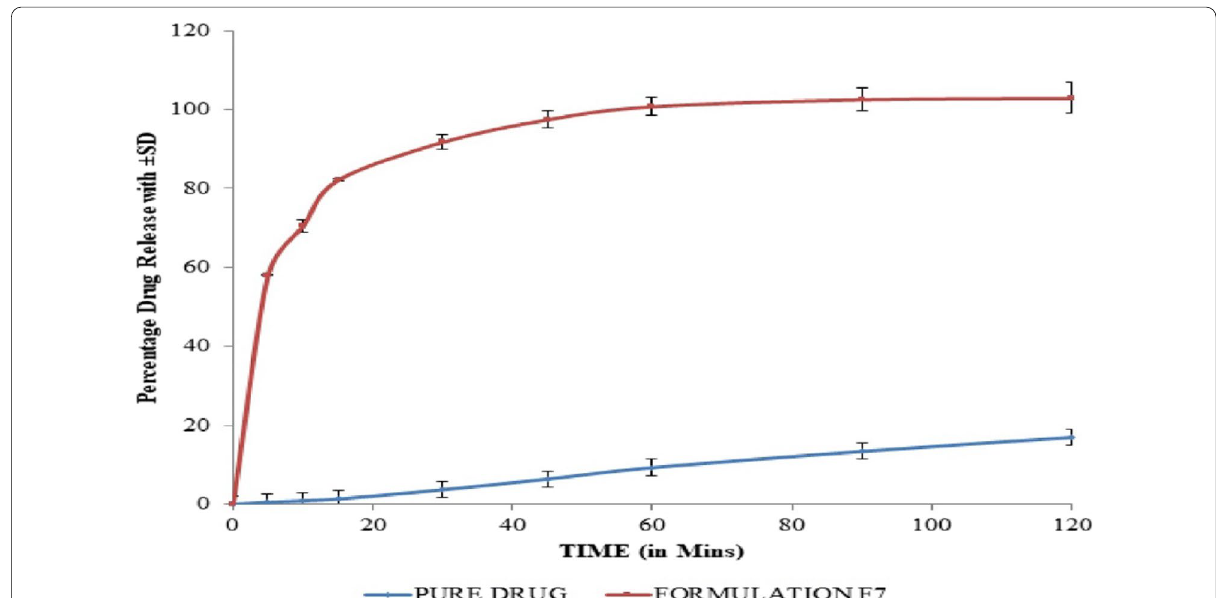
Fig. 4 Comparison of the percentage in vitro drug release between pure drug (vorinostat powder) and vorinostat-loaded optimized SMEDDS formulation (F7)